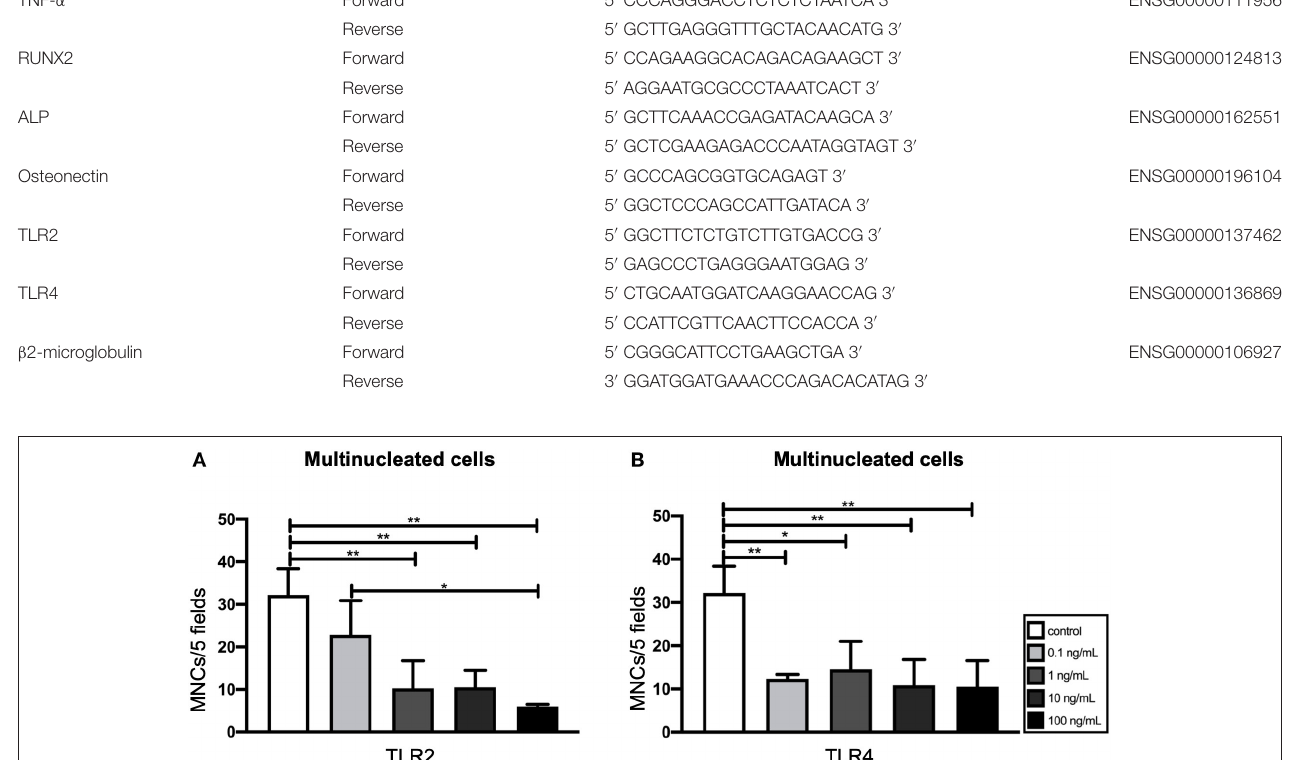
Frontiers in Immunology |